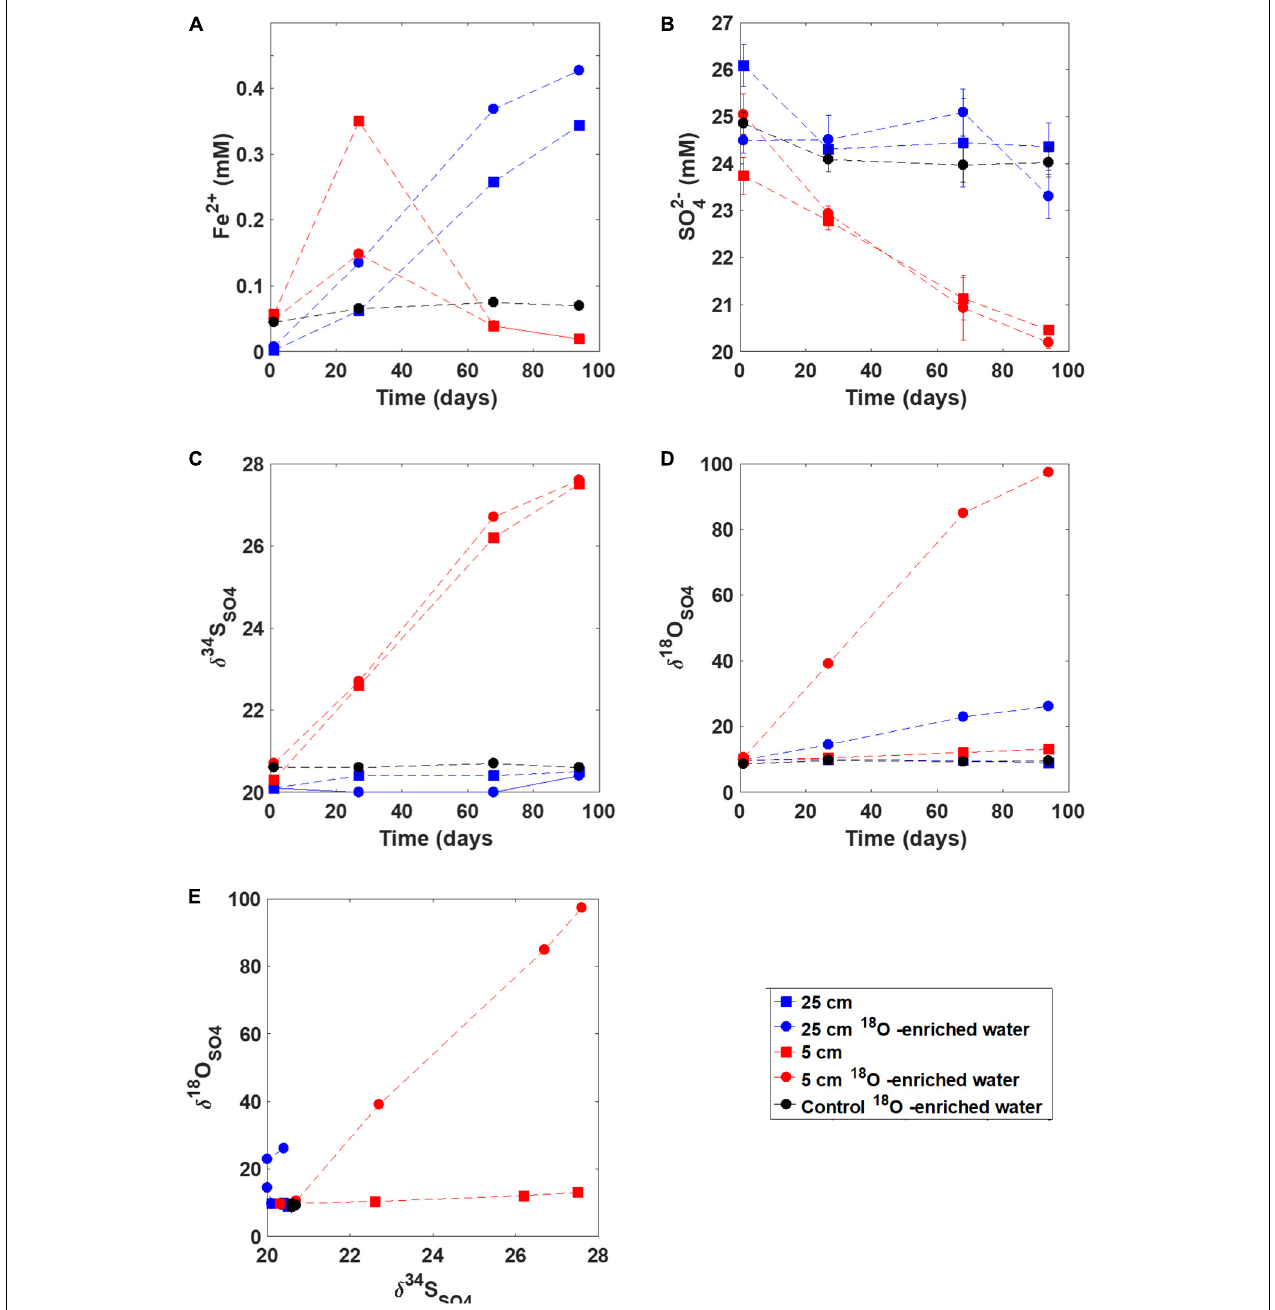
FIGURE 5 | Results from the slurry experiment. Panels (A–D) show the evolution of (A) ferrous iron concentration, (B) sulfate concentration, (C) d 34 S SO4 , and (D) d 18 O SO4 ; Panel (E) shows the d 18 O SO4 vs. d 34 S SO4 cross-plot for these